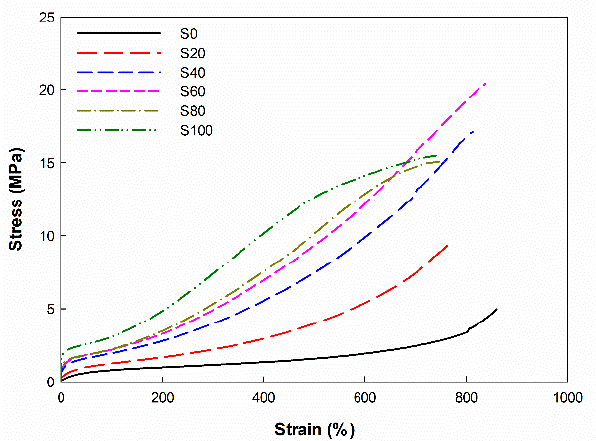
Figure 3. Stress–strain curve of the EPDM/silica vulcanizates. Table 3. Physical and mechanical properties of the EPDM/silica vulcanizates.